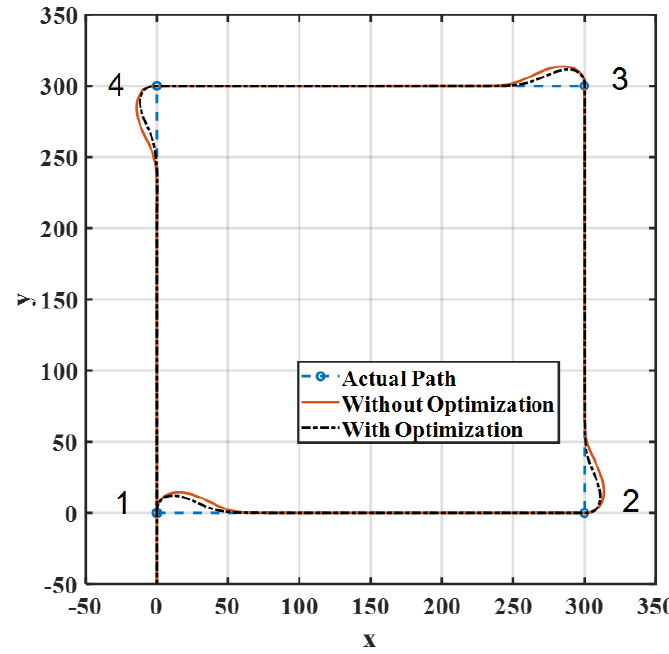
Figure 16. Lateral path using the optimized FLC.